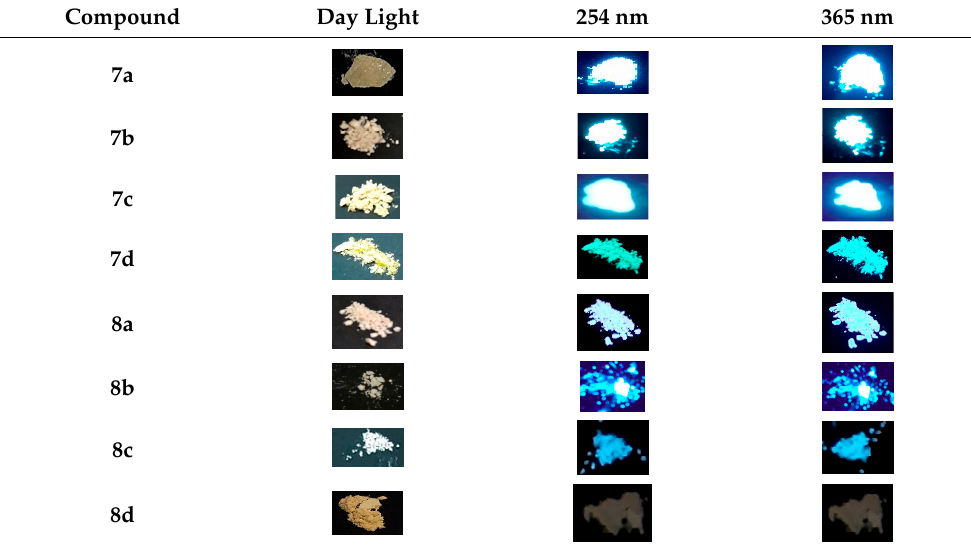
Figure 5. Emission spectra of ligands (red) and complexes (blue), in DMSO solutions (1.0 × 10 − 5 M, full line) and solid state (dotted line). All compounds exhibit a blue emission in solution and solid state (Figures 6 and 7). In solution, 8b , with a moderate quantum yield of 26%, exhibits a deep blue emission with CIE coordinates of (0.16, 0.02) with a y-component smaller than 0.04, that is highly desirable and follows the specifications of the European Broadcast Union (EBU) television (0.15, 0.06) [49,50]. In the solid state, all complexes emit a blue color under a UV lamp (Table 2). Both 8a (0.16, 0.04) and 8b (0.16, 0.08) present a deep blue color in the solid state.